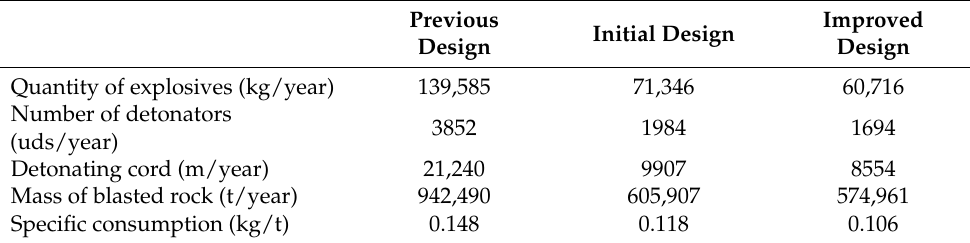
Table 9. Comparison of the initial design and its improvement over